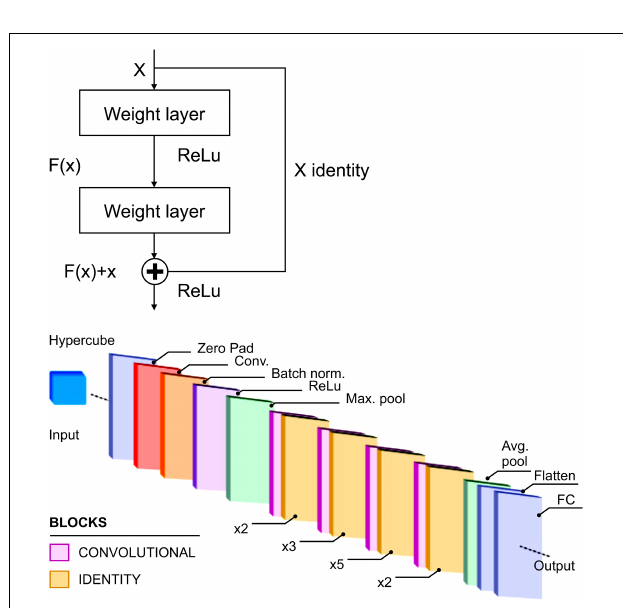
FIGURE 7 | Residual block concept (left) and Resnet-50 architecture (right) (Medus et al., 2021).